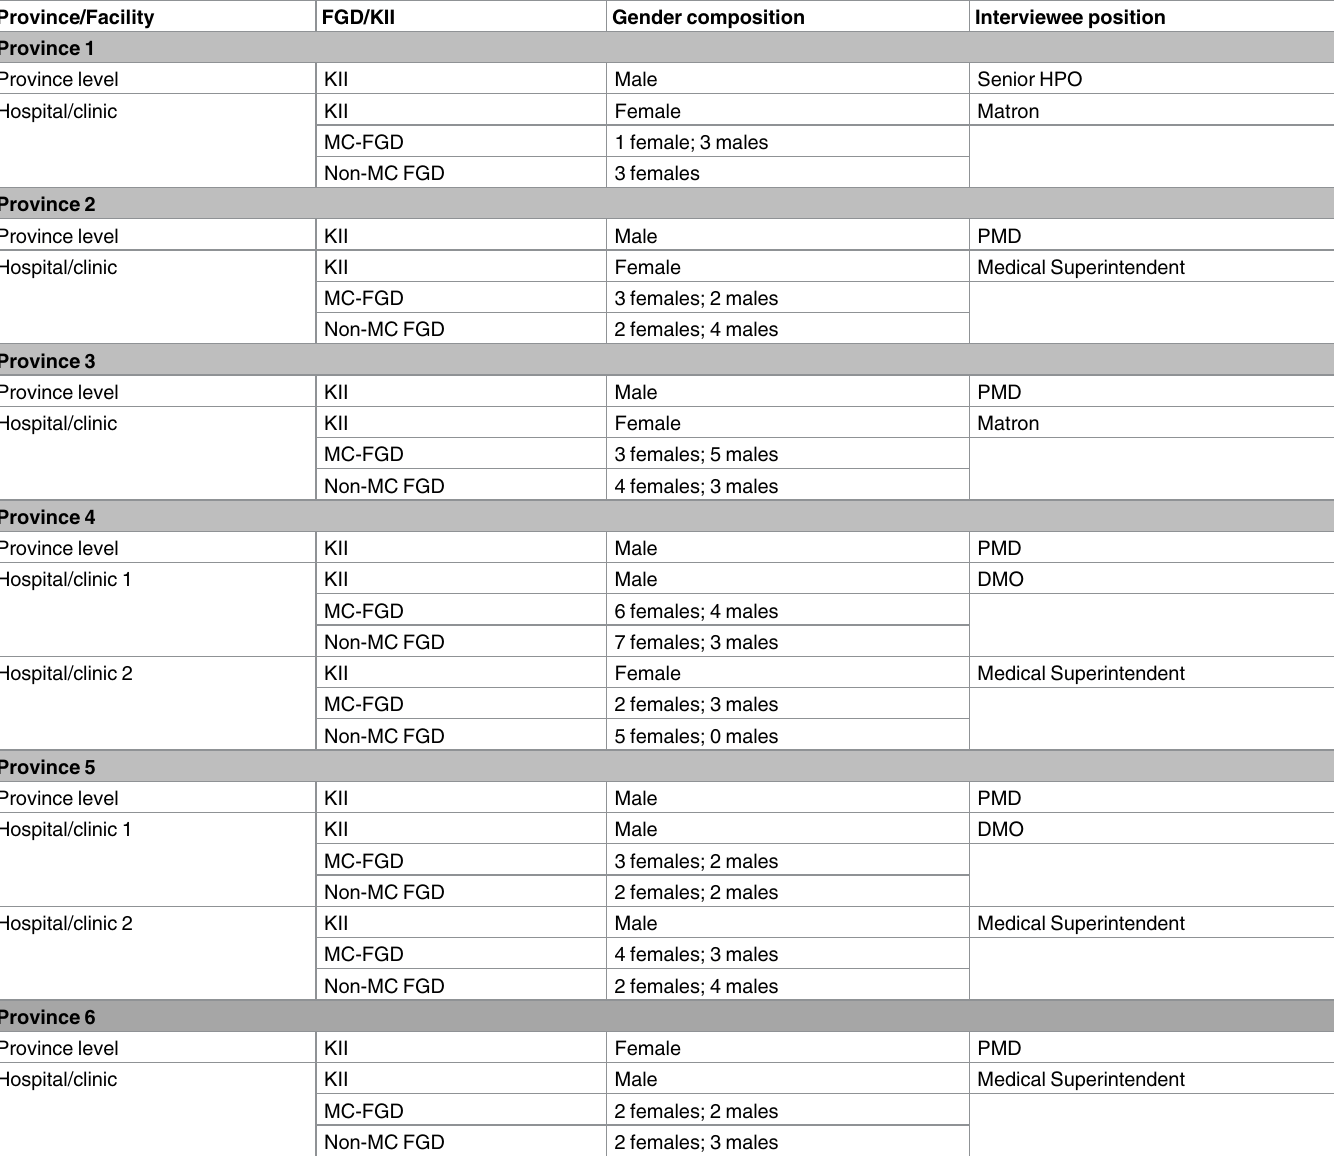
Table 2. Interviews and focus groups